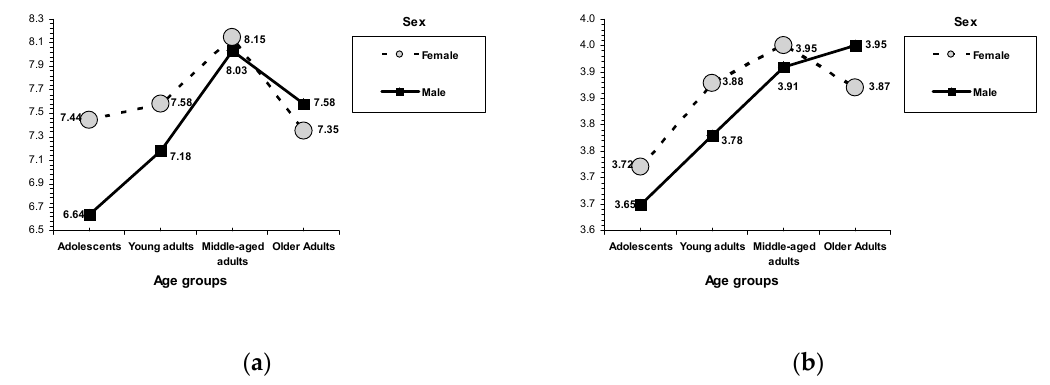
Figure 3. Interactions between sex and age. ( a ) Academic self-esteem and ( b )